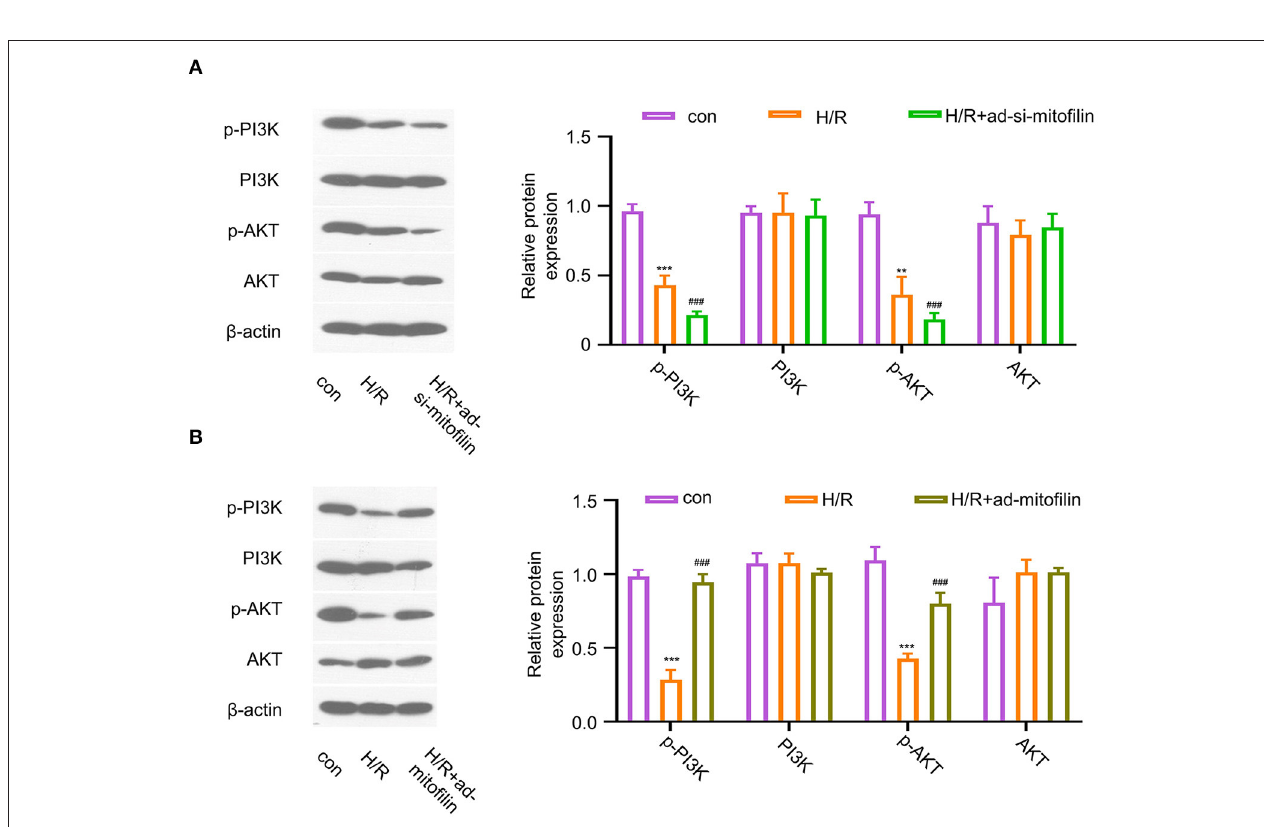
FIGURE 4 | Mitofilin regulates the PI3K/AKT signaling pathway. (A) The levels of p-PI3K and p-AKT in H9C2 cells were decreased after H/R induction, which were further decreased after the mitofilin knockdown. (B) The levels of p-PI3K and p-AKT in H9C2 cells were rescued after mitofilin overexpression. Con vs H/R: ** P < 0.01 and *** P < 0.001. H/R vs H/R + ad-si-mitofilin or ad-mitofilin: ### P < 0.001.